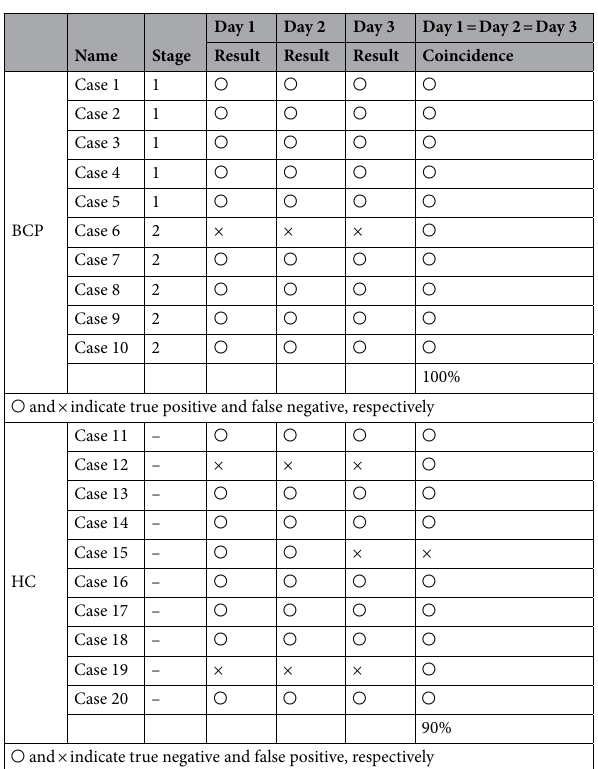
Table 4. The results of the reproducibility tests. BCP breast cancer patients, F female HC, healthy